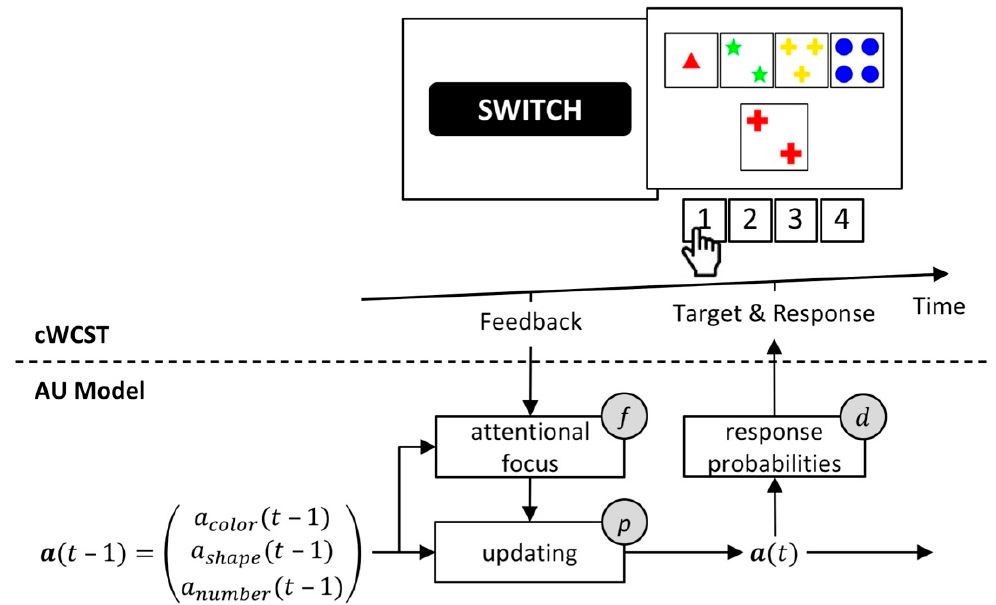
Figure 4. A schematic representation of the attentional-updating (AU) model [48]. Top: an exemplary sequence on a computerized WCST. Bottom: central to the AU model are attentional prioritizations (APs) of categories, a ( t ). APs from the previous trial a ( t − 1) are updated in response to a received feedback. Individual sensitivity parameters p quantify the overall strengths of updating. There are separate sensitivity parameters for trails following positive and negative feedback (not depicted). An attentional focus mechanism further modulates the strength of updating of AP (i.e., a high AP of a category results in strong updating of that AP and vice versa). An individual attentional focus parameter f quantifies the extent to which the magnitude of an AP modulates updating of that AP. An individual response variability parameter d quantifies the extent to which response probabilities correspond to updated AP, a ( t ).